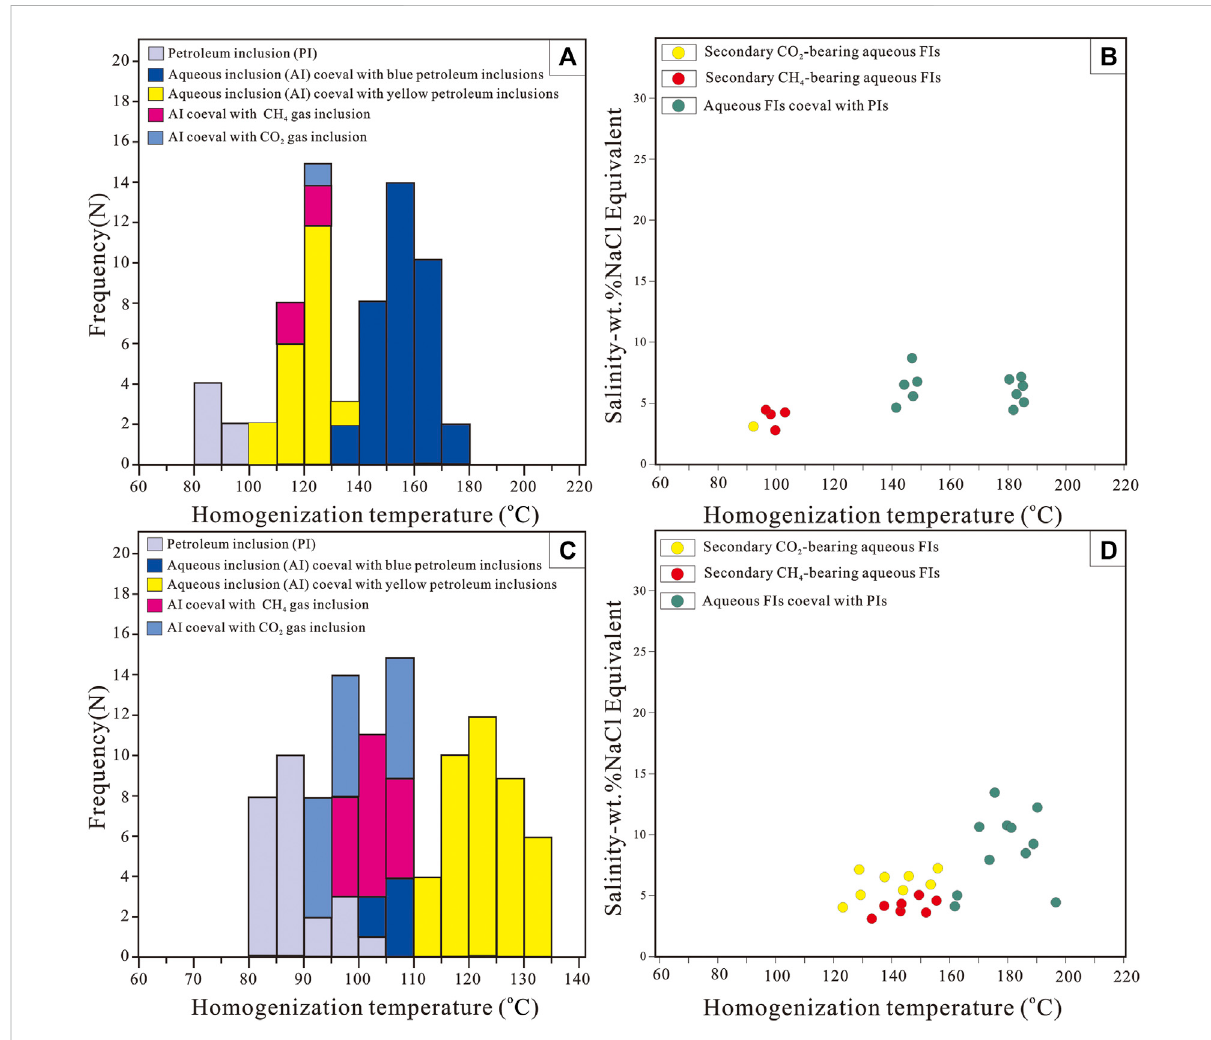
FIGURE 8 Homogenization temperature and salinity statistics of aqueous inclusions coeval with CO 2 , CH 4 , and petroleum inclusions in detrital grains in the Es 3 2 Formation of step I (A,B) and step II (C,D)